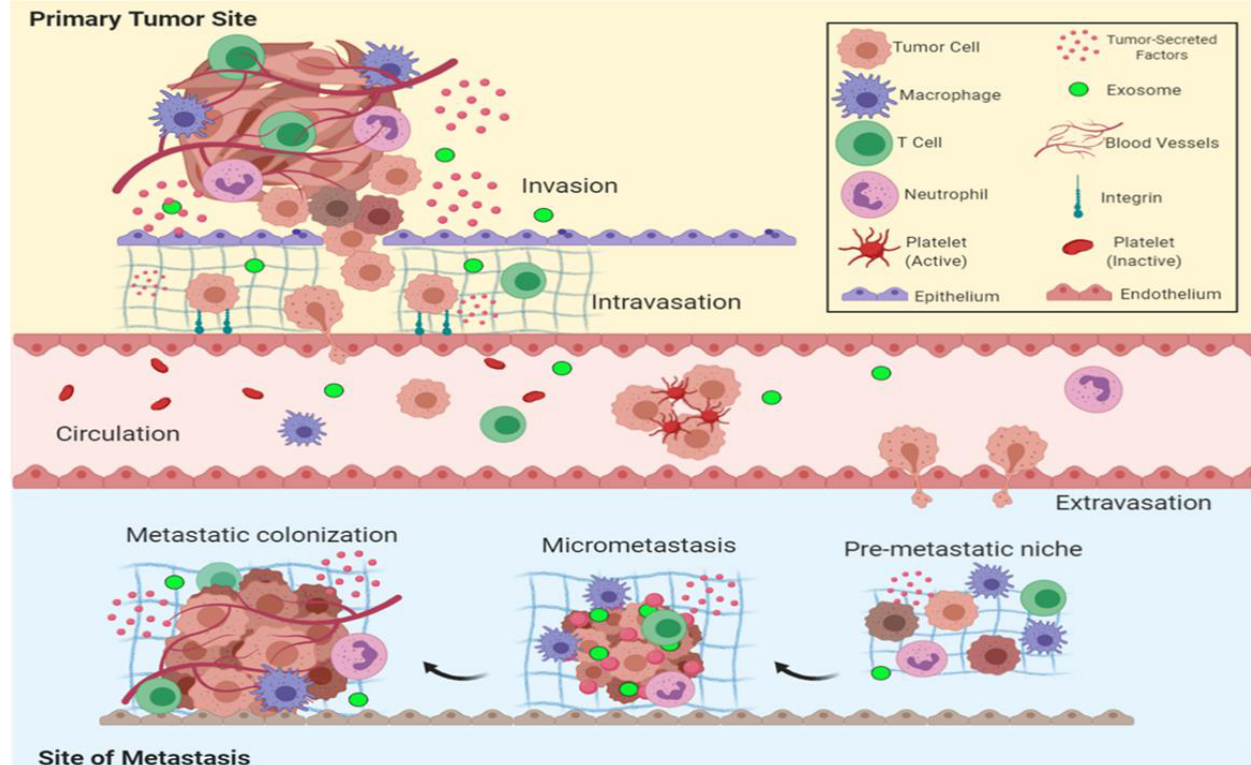
Figure 1. The steps leading to cancer metastasis. Initially, cancer cells breach the basement membrane and migrate across the cancer stroma. Next, intravasation into the blood vessels occurs and is followed by migration of the circulating cancer cells in the bloodstream until reaching the secondary metastatic site. Afterwards, extravasation of cancer cells through the endothelial barrier ensues; finally, colonization in the metastatic target organ forming a secondary cancer takes place [10].